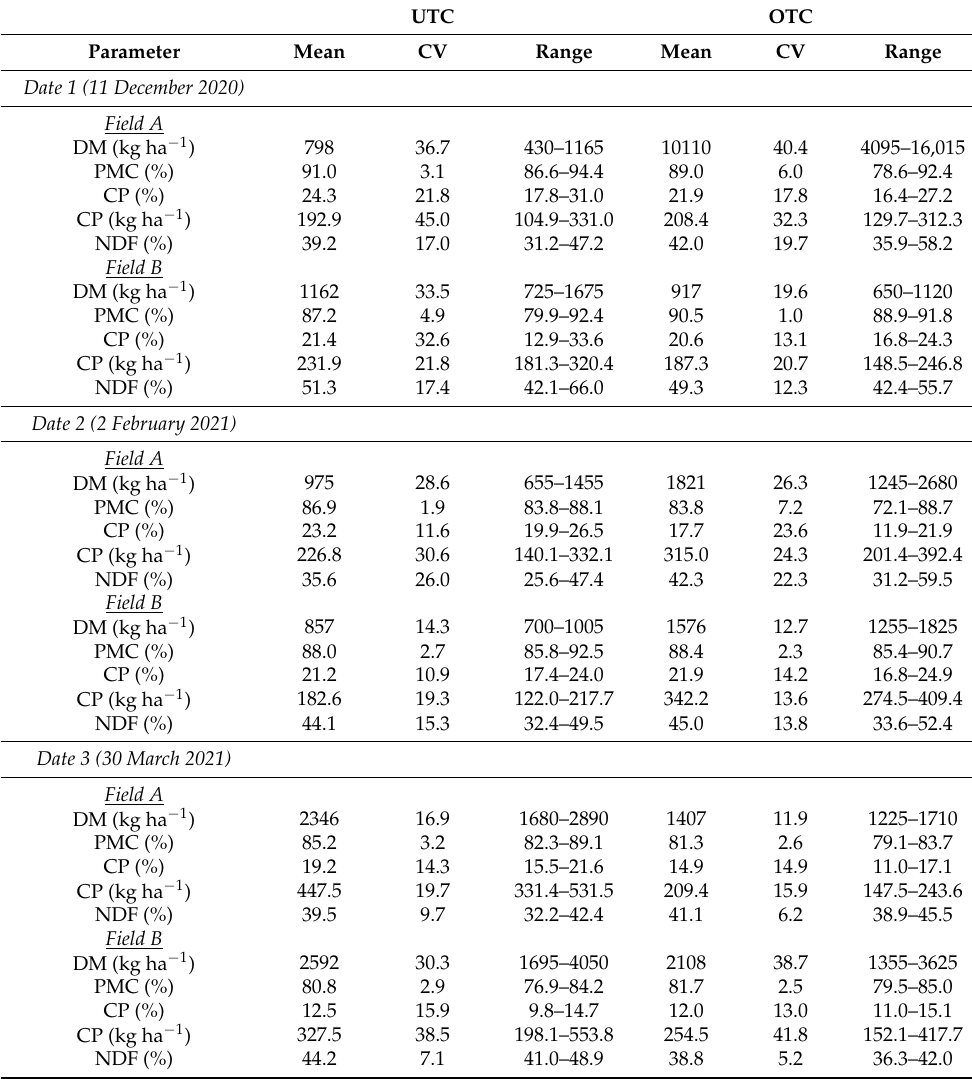
Table 3. Descriptive statistics (mean, coefficient of variation and range) of the pasture parameters in each of the two experimental fields (A and B) used in this